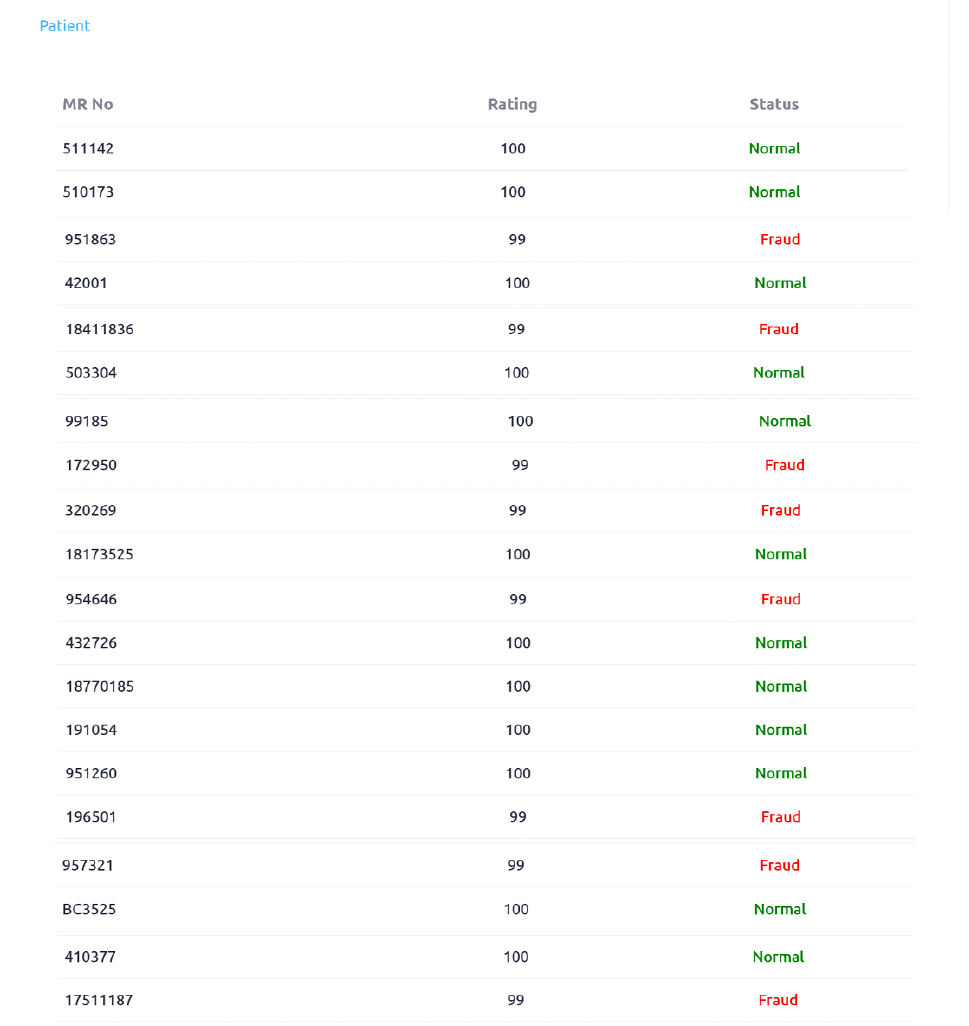
Figure 18. Patients Rating and